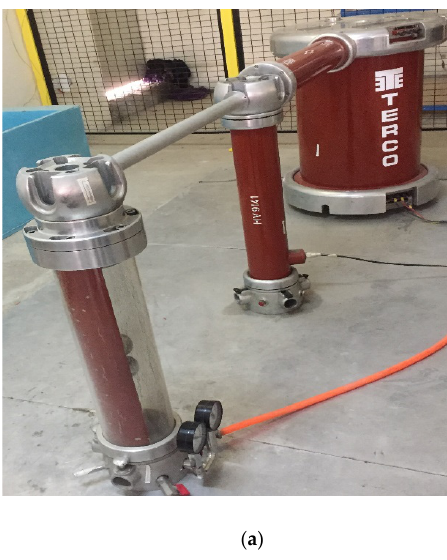
Figure 1. Schematic to examine R152a/CO 2 breakdown voltage by sphere–sphere electrodes.